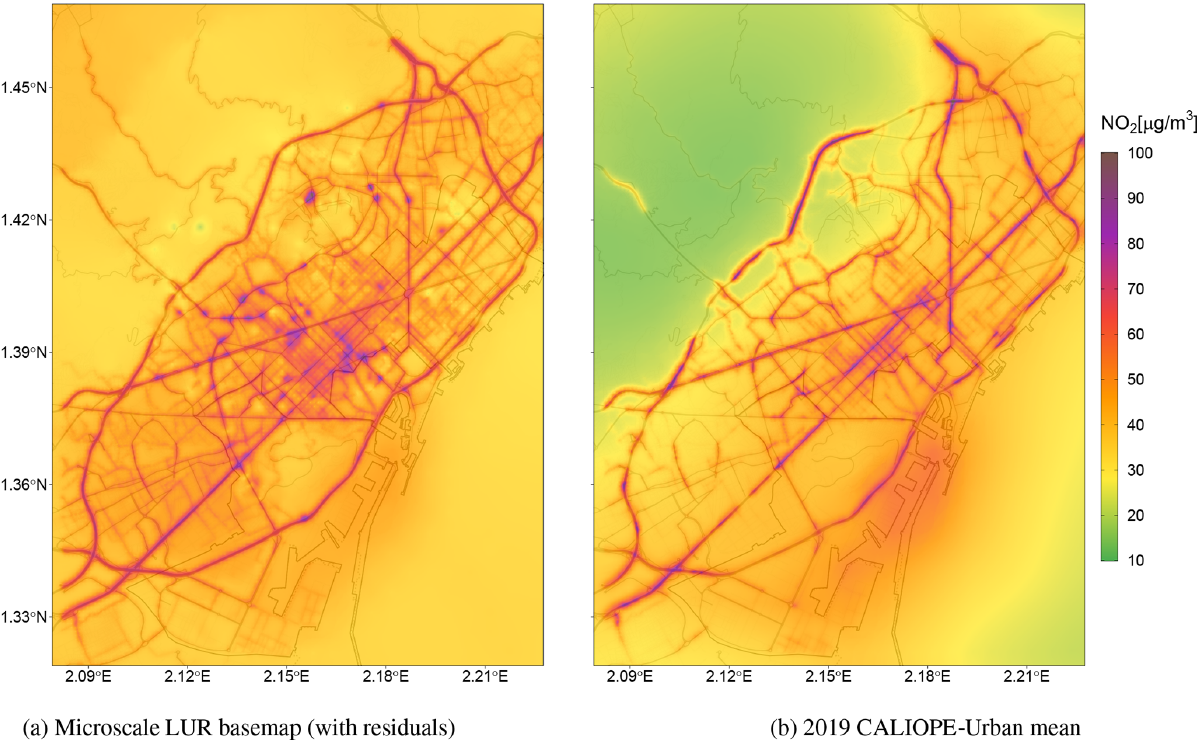
Figure 6. (a) Resulting microscale LUR basemap using all available sampling sites and adding the interpolated residuals. (b) The 2019 annual mean concentration of NO 2 of the raw dispersion model